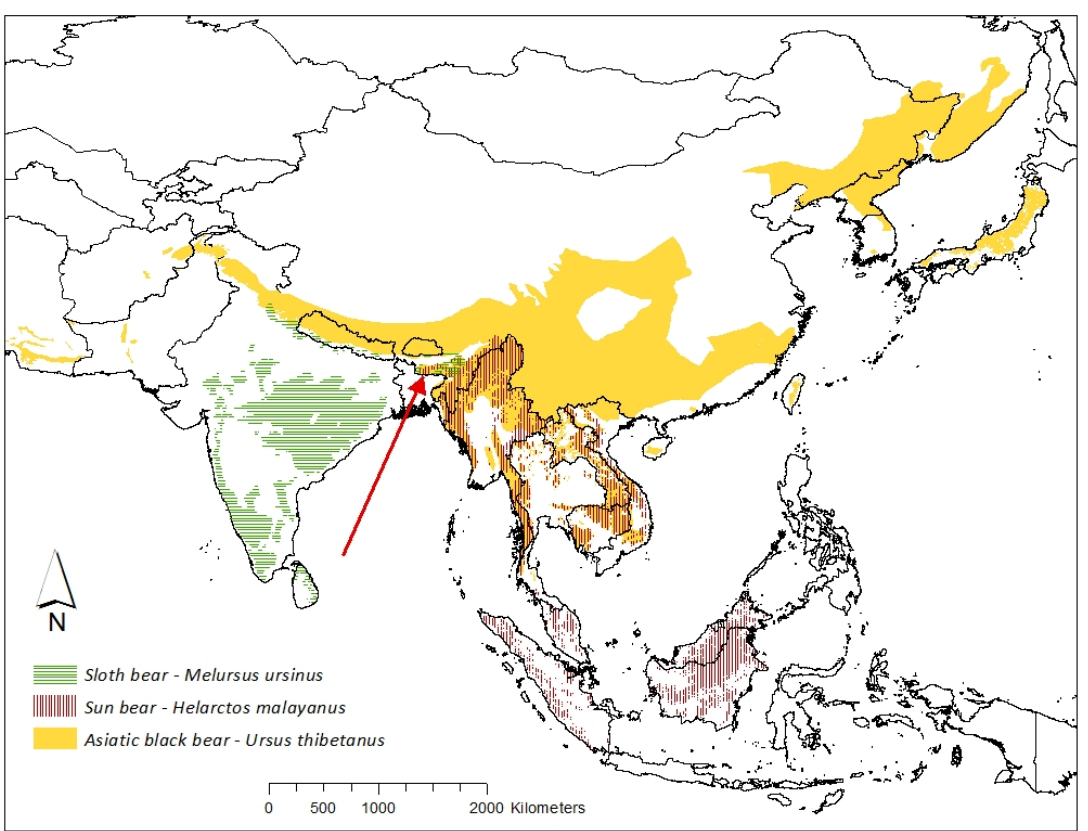
Figure 1. Range map of the three species of Asian bears that converge in Northeast India (red arrow). Depicted here is the maximum present range, combining categories for extant and possibly extant range from the IUCN (International Union for Conservation of Nature) Red List.